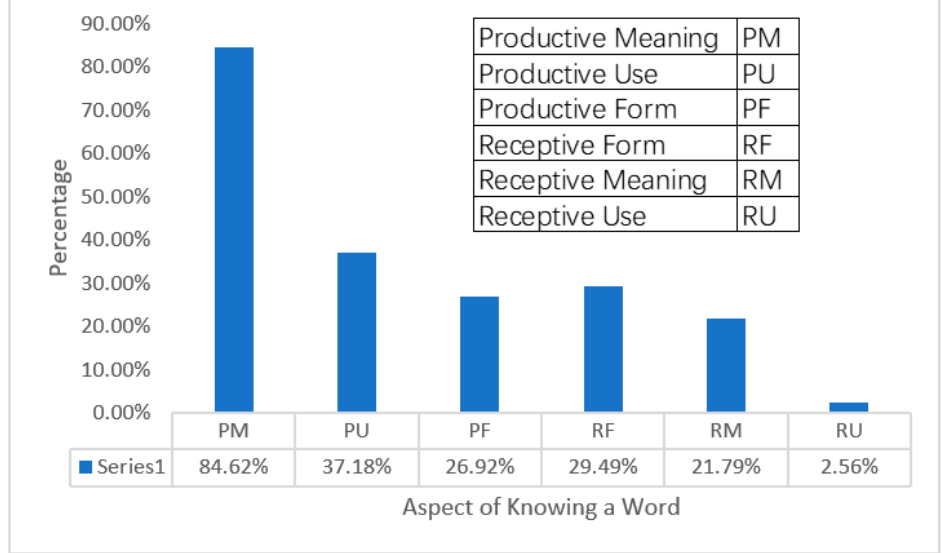
Figure 7. Aspects of knowing a word.